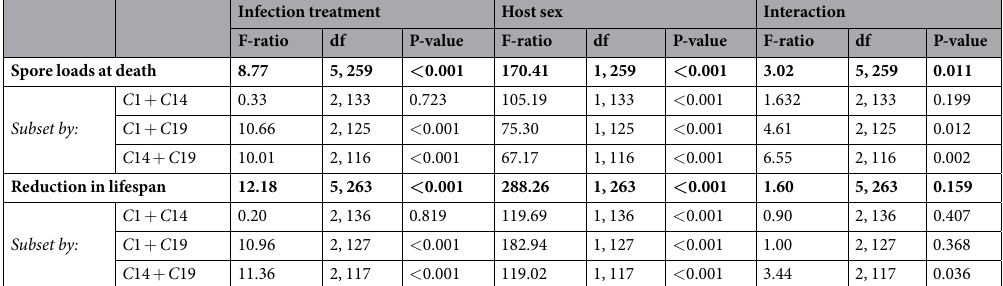
Infection treatment Host sex Interaction F-ratio df P-value